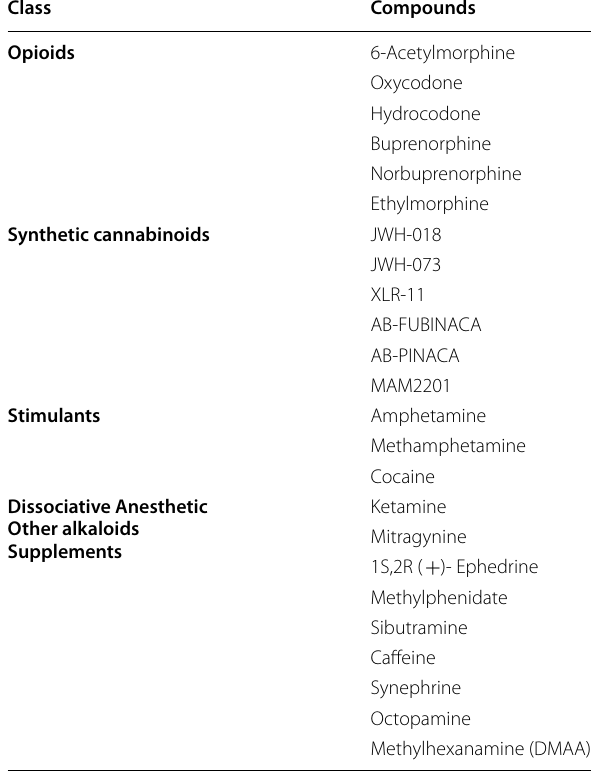
Table 2 List of compounds (methanolic standards) evaluated for possible interferences in the liquid